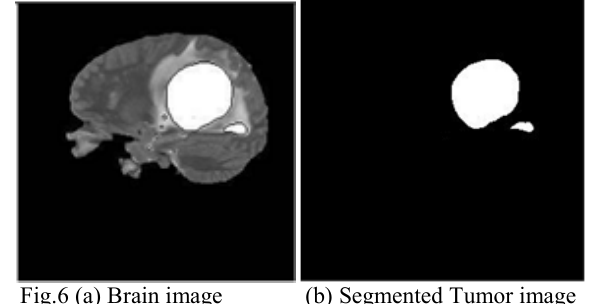
Fig.6 (a) Brain image (b) Segmented Tumor